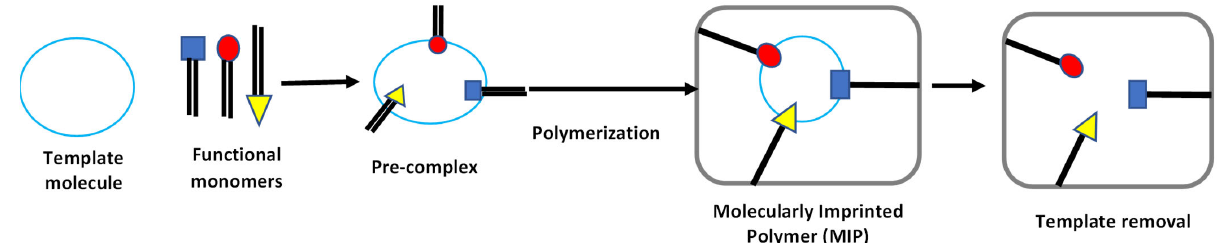
Figure 2. A generic schematic illustration for MIP synthesis. The fi rst step involves complexation of